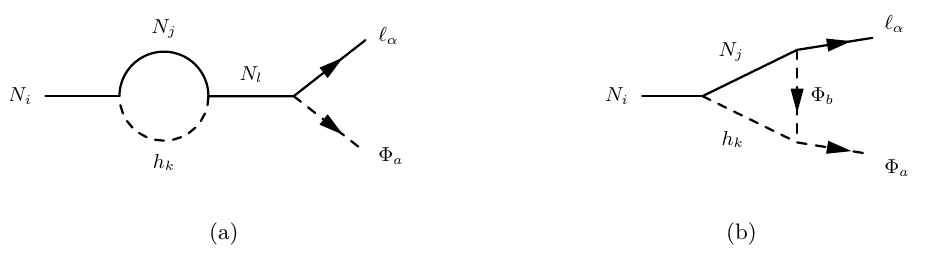
Figure 2 . New one-loop diagrams contributing to the CP asymmetry in N i → ‘ α Φ a decays via the interference with the corresponding tree-level diagram (a) of figure 1. (a) Wavefunction contribution ∼ O ( Y 2 ∆ 2 ) . (b) Vertex contribution ∼ O ( Y 2 ∆ µ ) .